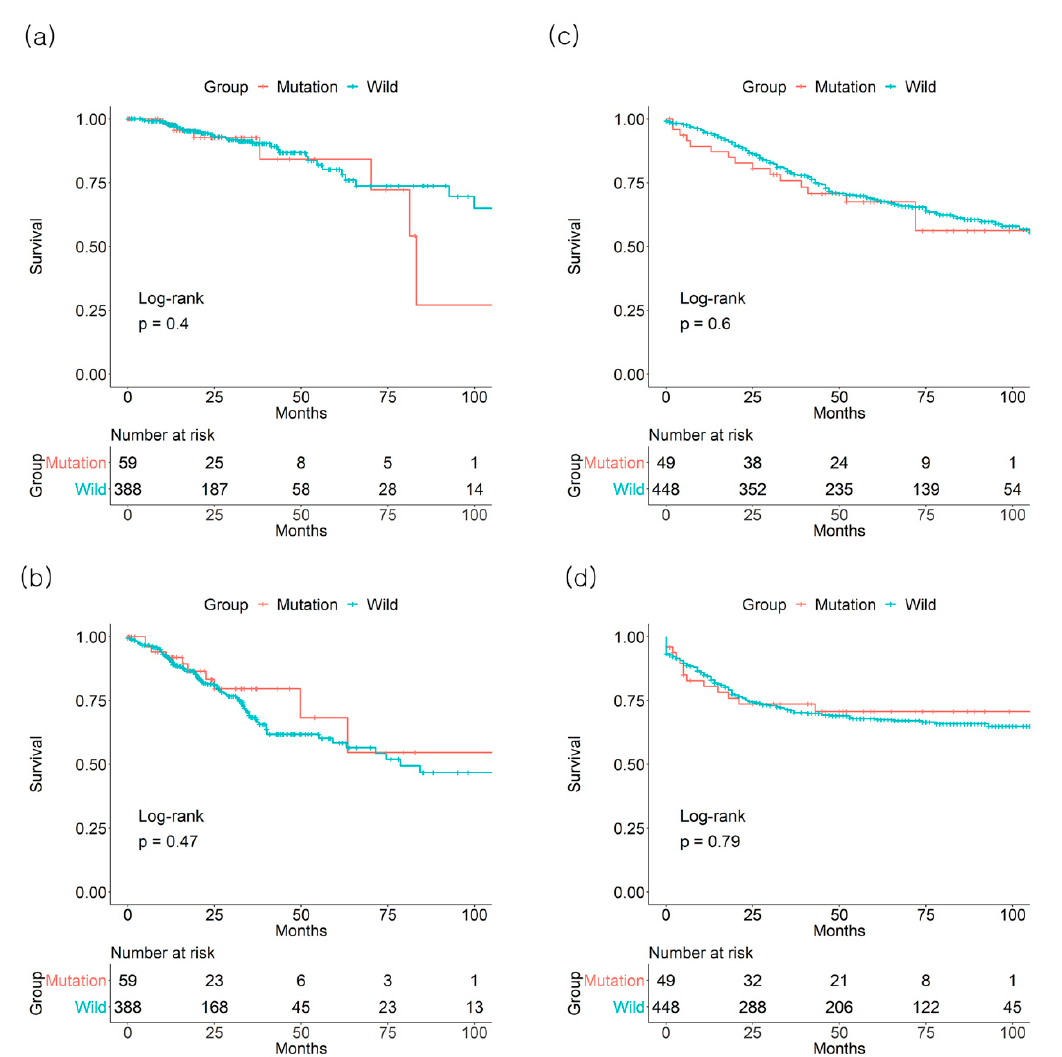
Figure 1. Effect of BRAF mutation on ( a ) 3-year overall survival and ( b ) 3-year disease-free survival from the The Cancer Genome Atlas (TCGA) database and on ( c ) 3-year overall survival and ( d ) 3-year disease-free survival from the Gene Expression Omnibus (GSE39582) database of colorectal cancer patients of all stages.